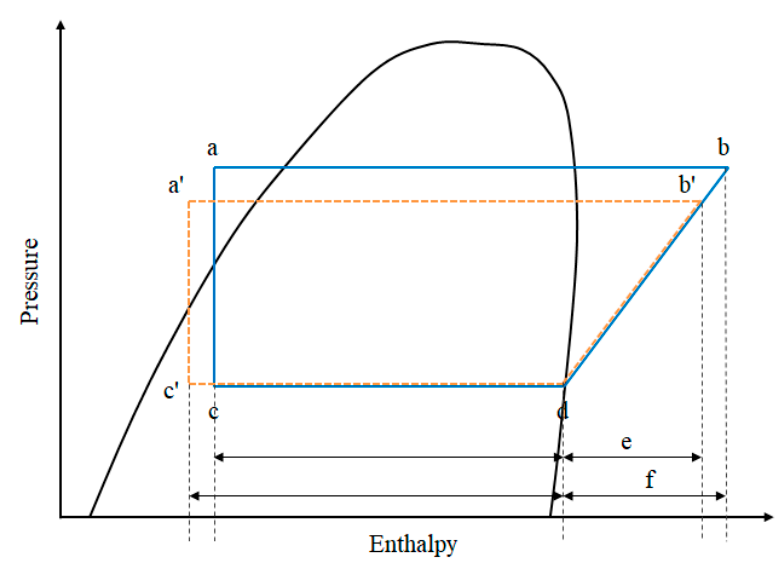
Figure 4. P-h (Pressure-Enthalpy) diagram of cooling operation.